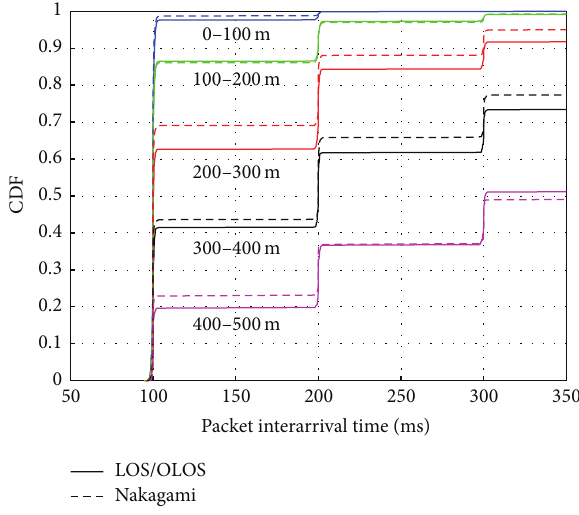
Figure 13: CDF for the packet interarrival time for a vehicle density of 100 vehicles/km for the LOS/OLOS and Nakagami models,